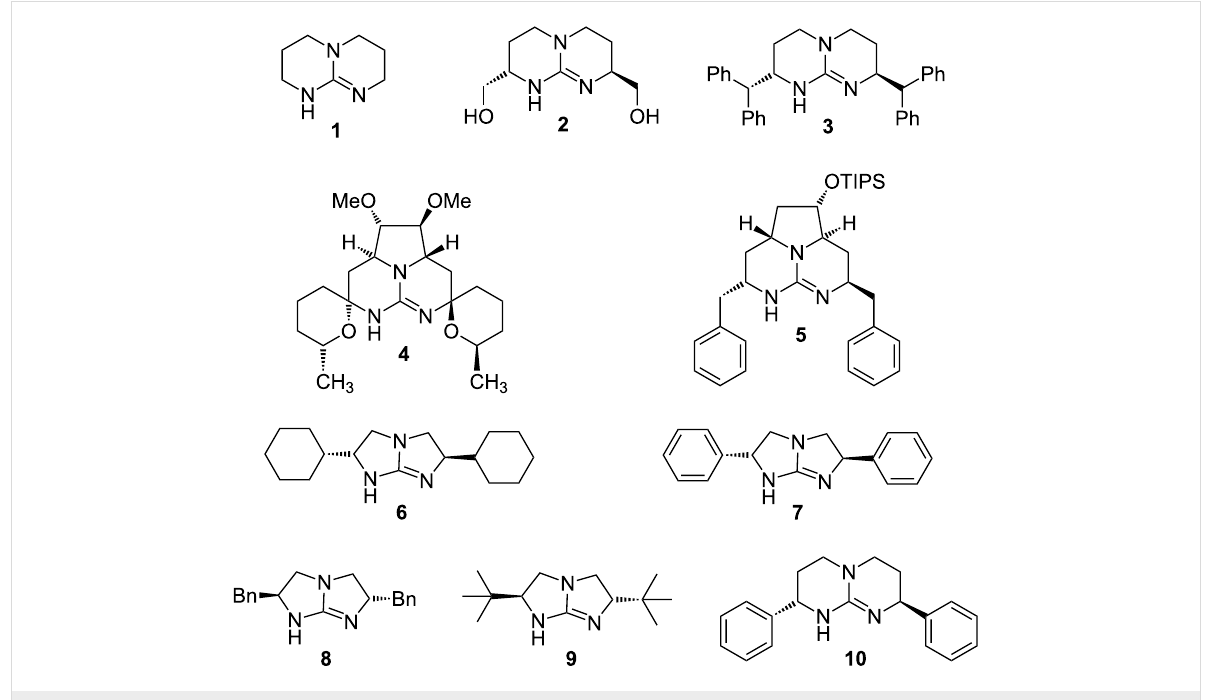
Figure 1: Structure of guanidines 1 – 10 .